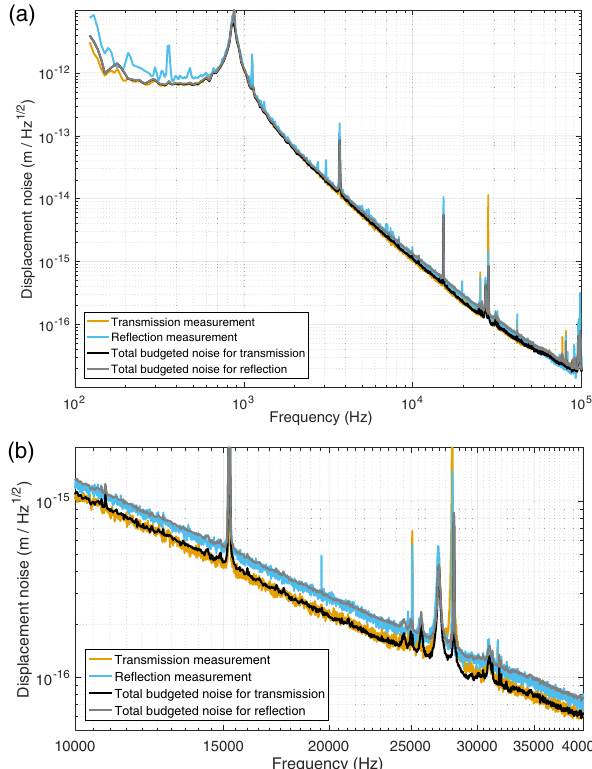
FIG. 4. Measured and budgeted total noise for the transmission and reflection measurements across the entire measurement bandwidth (a) and the frequency range where the backaction cancellation is largest, with a maximum reduction in the total displacement noise of 2 dB (b). The total budget noise for each measurement consisting of the sum of the individual noise sources shown in Fig.